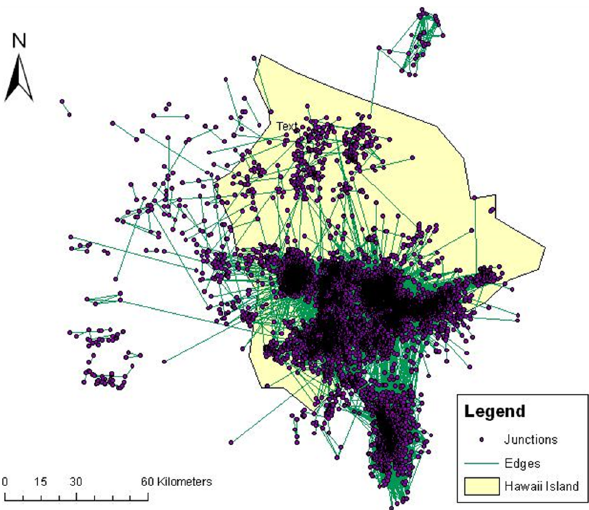
Fig. 1. The earthquake network: an example for the Big Island of Hawaii.